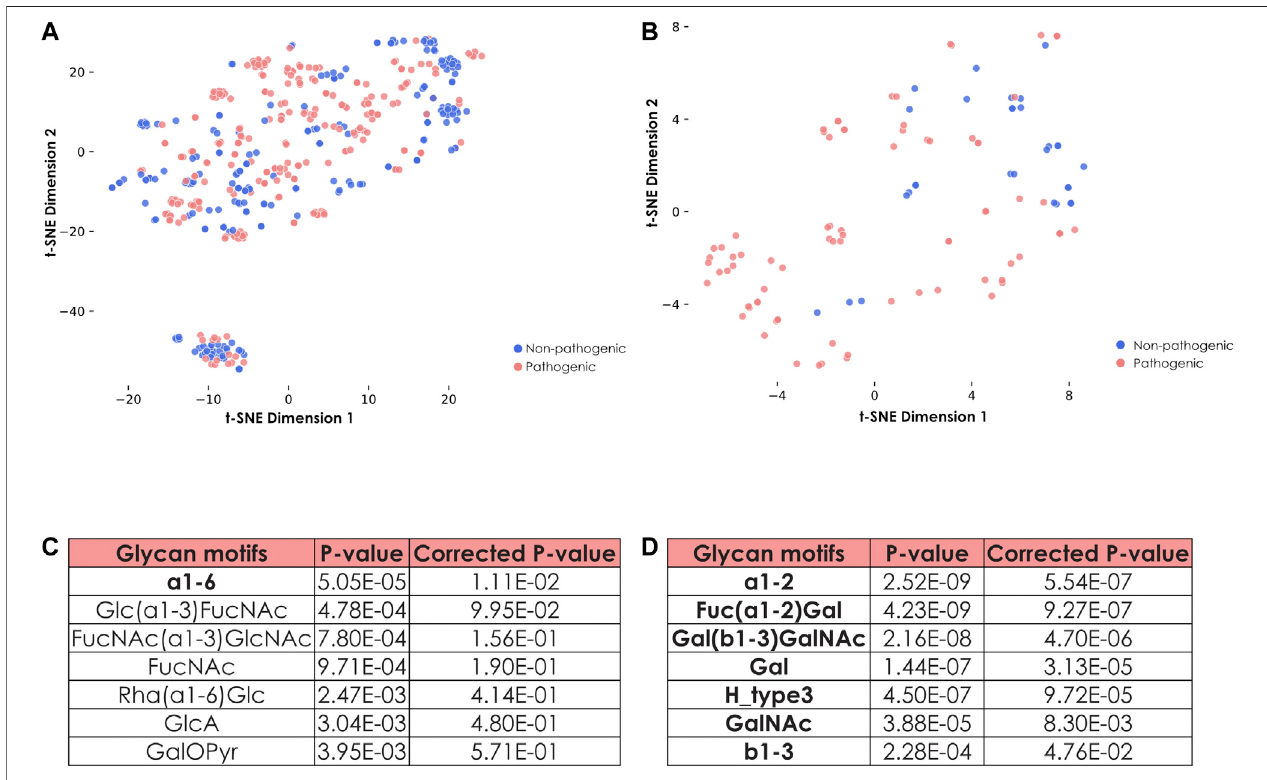
FIGURE 5 | Speci fi c features of fucosylated glycans from pathogenic and non-pathogenic E. coli strains. (A) Representation of all glycans from pathogenic and non-pathogenic E.coli strains.Shown isat-SNEgraphrepresentingallglycansfromboth pathogenicandnon-pathogenic E.coli strainsviatheirlearnedsimilarities bya SweetNet model. Colors indicate the group from which they stem. (B) Representation of fucosylated glycans from pathogenic and non-pathogenic E. coli strains. Fucose-containing glycans from both groups of E. coli strains are visualized with their learned similarity via t-SNE. (C) Identi fi cation of speci fi c motifs from fucosylated glycans to distinguish groups of E. coli strains. To determine speci fi c motifs from fucose-containing glycans for non-pathogenic versus pathogenic E. coli strains, we computed their statistical enrichment with one-tailed Welch ’ s t-tests and a Holm- Š ídák correction for multiple testing. Motifs indicated in bold have a corrected p -value inferior to 0.05. (D) Identi fi cation of speci fi c motifs for pathogenic E. coli strains. Similar as in (C) , we computed statistical enrichment of motifs from pathogenic versus non-pathogenic E. coli